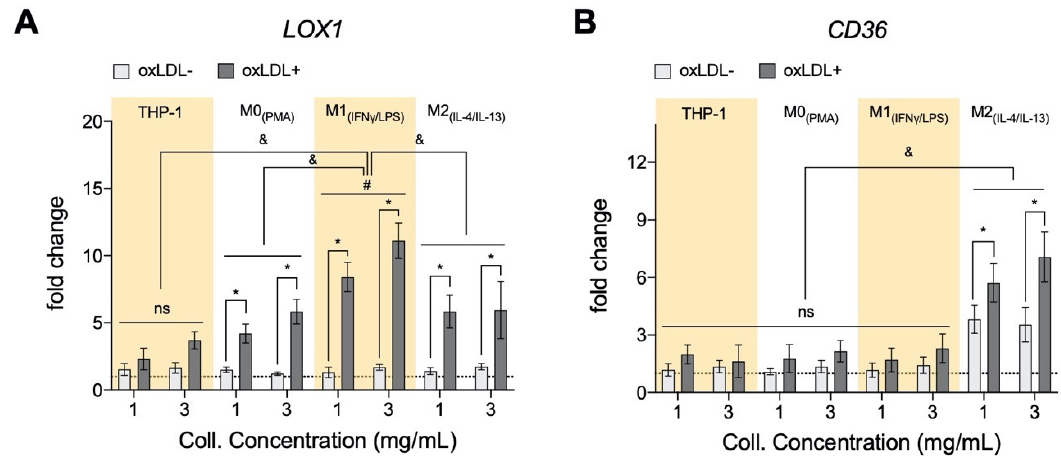
Figure 2. Expression of oxLDL receptors of monocytes and macrophages cultured in 3D collagen matrices. ( A ) There is an increase in gene expression of lectin-like oxidized low-density lipoprotein receptor-1 ( LOX1 ) in both monocytes (THP-1) and significantly in all macrophage subtypes when cells are cultured in 3D collagen hydrogels and exposed to oxLDL. Significantly, M1 + LDL exhibited the highest fold induction and THP-1 + LDL, the lowest, with M0 + LDL and M2 + LDL comparable. LOX1 expression only changed significantly in M1 with collagen concentration ( x -axis, 1 mg / mL to 3 mg / mL). ( B ) Genetic expression of CD36 , another oxLDL receptor, was only measurable in M2 + LDL, and significantly higher expression was found in lower density collagen hydrogels. All significances represented as p < 0.05, * compared to untreated sample at the same matrix condition, & between oxLDL samples of di ff erent cell types at the same matrix condition, and # significant change with collagen concentration. The dotted horizontal line indicates a level of no change.